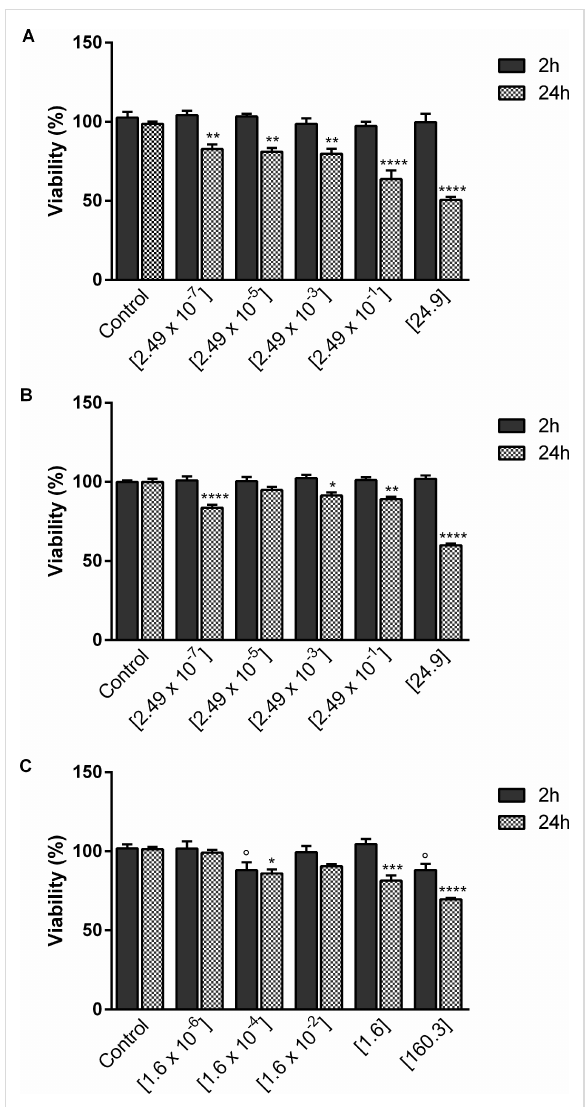
Figure 1: Concentration-dependent effects of PCL- (A), PLLA- (B) and Au- (C) NPs on rBCEC4 cell viability. A time- and concentration-de- pendent effects was detected after exposure to all three types of NPs. Concentrations of PCL- or PLLA-NPs were [2.49 × 10 − 7 µg/mL] to [24.9 µg/mL] and of Au-NPs [1.6 × 10 − 6 µg/mL] to [160.3 µg/mL] with 100-fold increases in between. Error bars represent SEM. Control: non-exposed cells. Significant differences between NP-exposed and non-exposed control are labeled with circles (°) for 2 h of NP exposure and asterisks (*) for 24 h of NP exposure, respectively (°/* = p ≤ 0.05; ** = p ≤ 0.01; *** = p ≤ 0.001; **** = p ≤